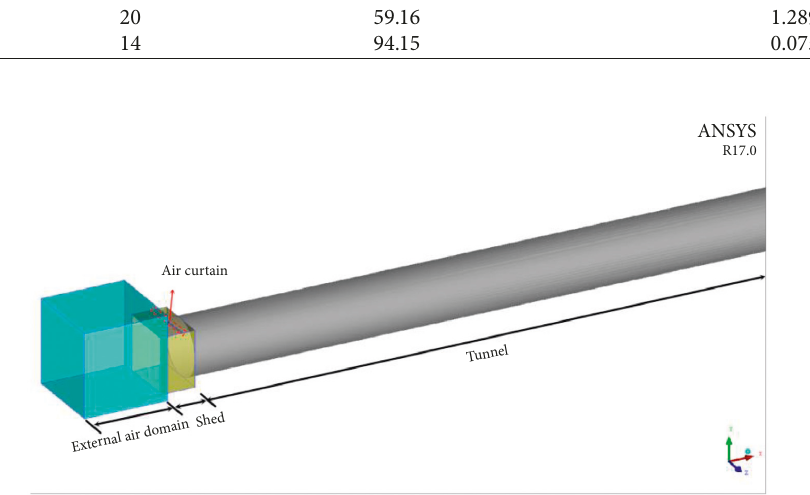
Figure 7: Finite element model.